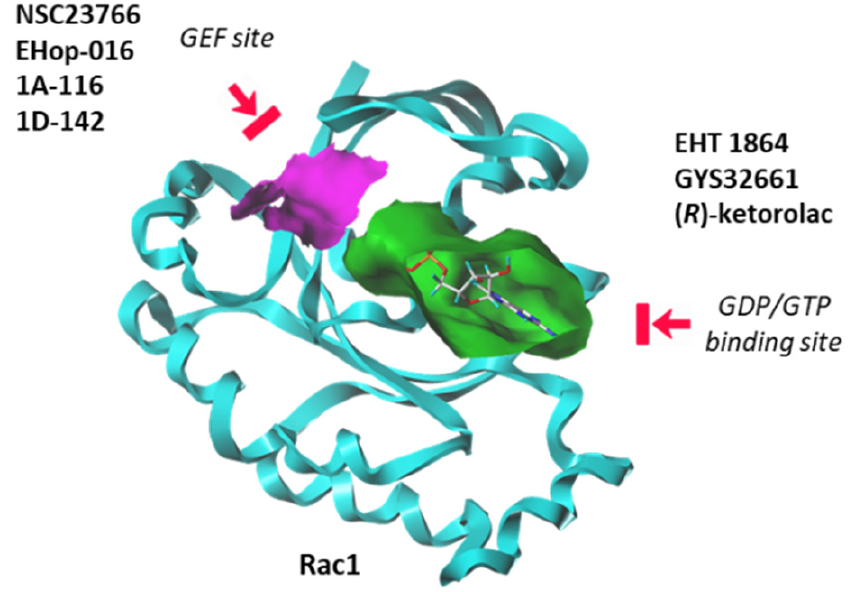
Figure 6. Two categories of Rac1 inhibitors. Some compounds fit into the GTP/GDP-binding site (in green) whereas other compounds bind to the GEF-binding site (in purple) and function as interrupters of Rac1-GEF interactions.